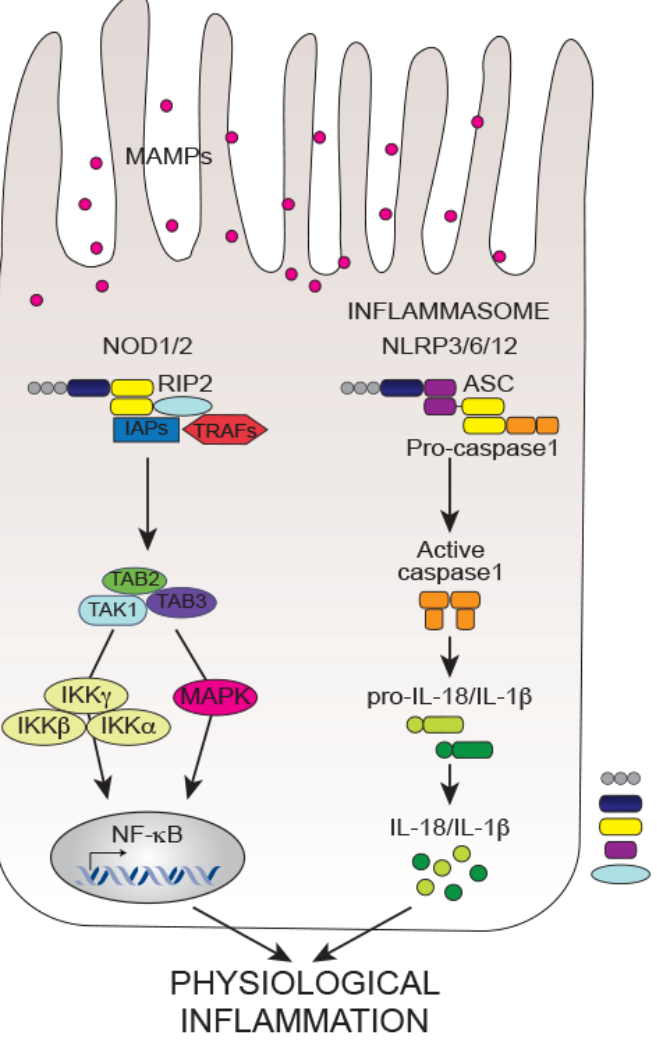
Figure 2. Simplified NLR pathways engaged in intestinal homeostasis. Upon microbial sensing, NOD1 and NOD2 recruit the adaptor protein RIP2 via CARD-CARD interactions. Activated RIP2 binds to the E3 ubiquitin ligases TRAFs and IAPs triggering NF- κ B and MAPK signaling. Similarly, the adaptor protein ASC bridges the activated inflammasome NLRs (NLRP3, 6 and 12) to pro-caspase-1 through both PYD and CARD domains, respectively. Formation of the inflammasome complex triggers auto-proteolytic cleavage and activation of caspase-1 subsequently leading to maturation and release of IL-1 β and IL-18. Activation of both NOD signaling and inflammasome pathways contributes to the maintenance of intestinal homeostasis against resident commensal